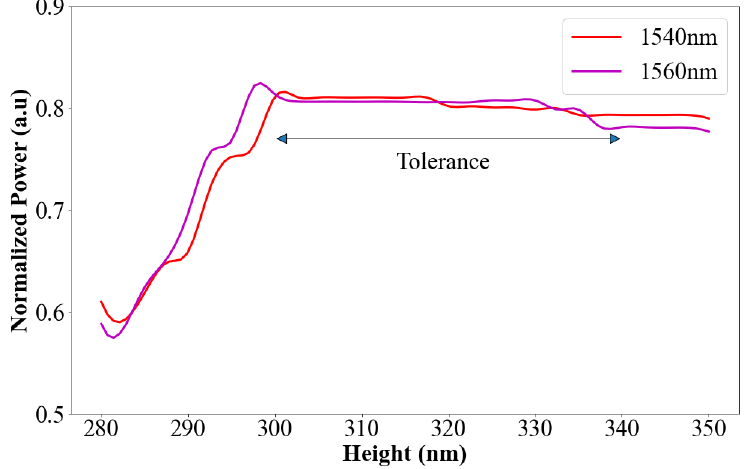
Figure 3. Normalized power as a function of SiN strip height.